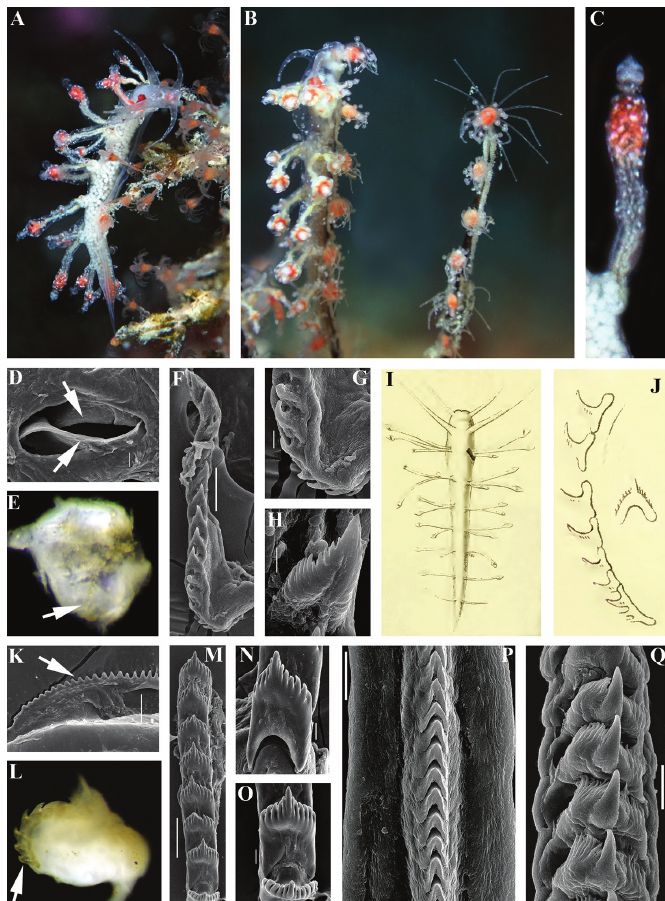
Figure 1. Comparison of Myja longicornis Bergh, 1896 with other aeolidacean taxa that have been pro- posed to have relationships with it ( Calma , Tergipes ) and which are covered by present analysis [type spe- cies of the genus Facelina , F. auriculata (Müller, 1776)]. A–H Myja cf. longicornis from Thailand, living animal ca. 10 mm in length A dorsal view of hydroids in situ B lateral view of hydroids in situ (left), egg mass on the hydroid (right) C details of cerata D smooth masticatory processes of jaws (indicated by arrows), SEM E pharynx, dissected dorsally to show very narrow radula (indicated by an arrow), LM F whole radula, SEM G anteriormost part of radula to show sacoglossan-like small knife-shaped teeth, SEM H teeth from the middle part of radula, SEM; I, J Myja longicornis Bergh, 1896 external view and radula (anterior part), reproduced from the first description by Bergh (1896); K–O Facelina auriculata jaws and radula of a specimen from UK, collected together with neotype K masticatory process (well- defined denticles indicated by arrow), SEM L radula (arrow) on odontophore, to show that anteriormost teeth are not reduced, LM M anterior part of radula to show that teeth are not reduced N anteriormost tooth of radula O two anterior teeth of radula P radula (middle part) of Calma glaucoides (Alder & Hancock, 1854) from Norway Q radula (middle part) Tergipes tergipes (Forsskål in Niebuhr, 1775). Scale bars: 20 μm ( D, N, O, Q ); 50 μm ( F, K ); 10 μm ( G, P ); 5 μm ( H ); 100 μm ( M ). Photographs of living specimens by Chanon Ngernthongdee and Siwat Worachananant, SEM images by AV Martynov. Figures I and J are reproduced from Bergh (1896), the publication not currently under